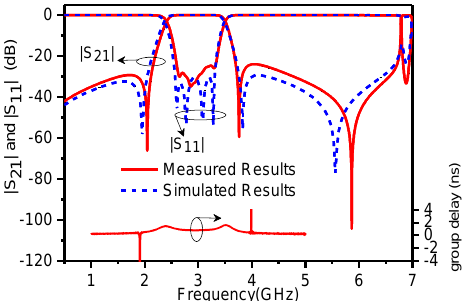
Figure 8. Simulated results (dotted) and measured results (solid) of reflection and transmission coefficients of the quadruple-mode filter with measured group delay.